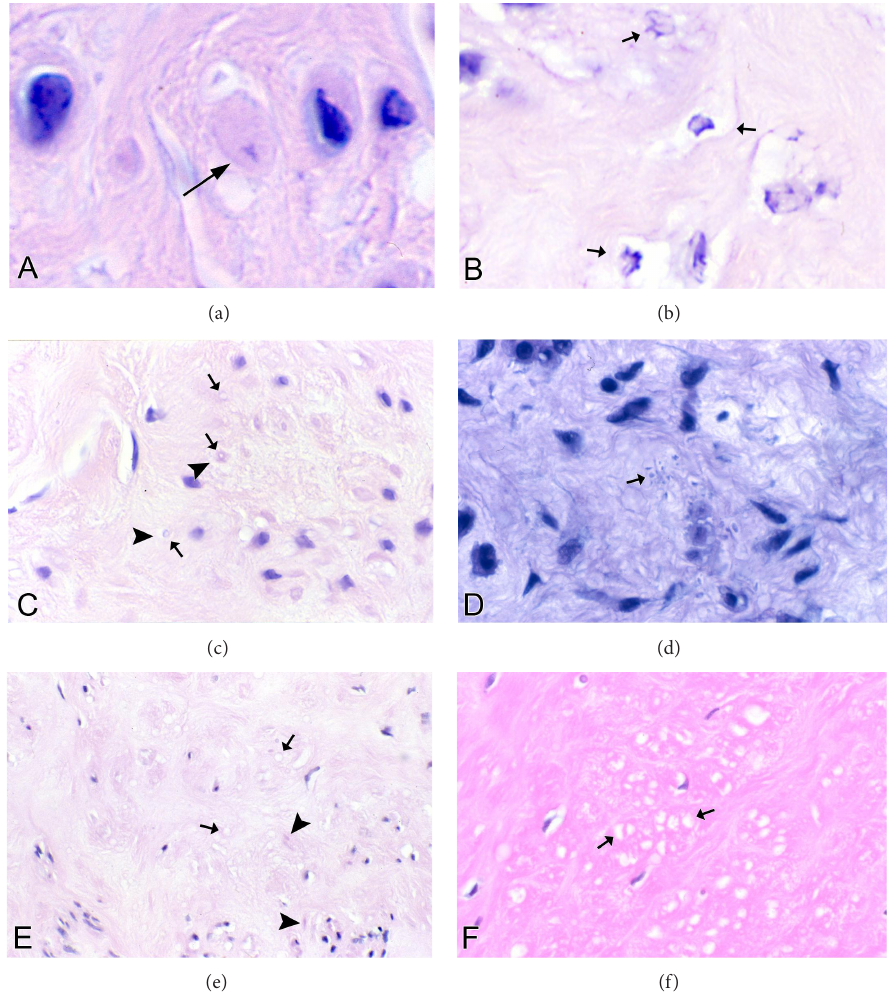
Figure 16: Reclamation. Cytologic and histologic changes are sometimes noted in involuting fibroids that are suggestive of cell resorption, a process that we refer to as reclamation. Angulated nuclear shapes, such as the triangular shaped nucleus in (a) (arrow) and the burr-shaped nuclei (acanthanuclear alteration) in (b) (arrows), are aberrant shapes that would not be expected in viable cells and may be related to loss of nuclear membrane integrity. Structures that appear to be hollow or empty nuclei, with only a shell of surrounding cytoplasm, are noted in (c) (arrows), and these structures often lie within clear spaces in the stroma that may represent resorption pits (arrowheads). Small fragments of probable cytoplasmic material are sometimes noted within clearings in the stroma, as seen in (d) (arrow); whether these are discarded lateral buds or decapitated particles of cell cytoplasm is uncertain. Finally, clear, circular spaces are sometimes noted within hyalinized areas of Phase 4 tumors, as seen in (e) and (f) (arrows) that are believed to be the end stage of the reclamation process. In (e), inanotic dead cells are also noted (arrowheads). In (f), the clear spaces are numerous, resulting in a spongiform appearance. Original magnification of (a): 330x, (b): 330x, (c): 330x, (d): 198x, (e): 132x, and (f):